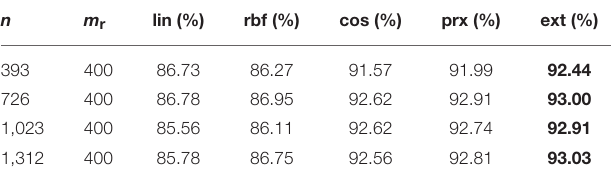
FIGURE 1 | (A) Color maps of the exact kernel K ext on S 2 at rescaled time t * t * log 3 / 3. (B) Plots of the parametrix kernel K prx and exact kernel K ext on S n − 1 , for n time approximately equal to t = distance.